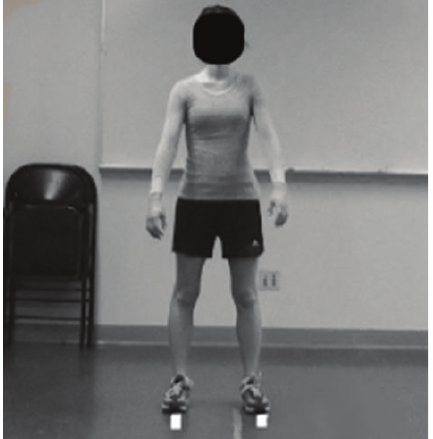
Figure 1: Tuck jump assessment starting